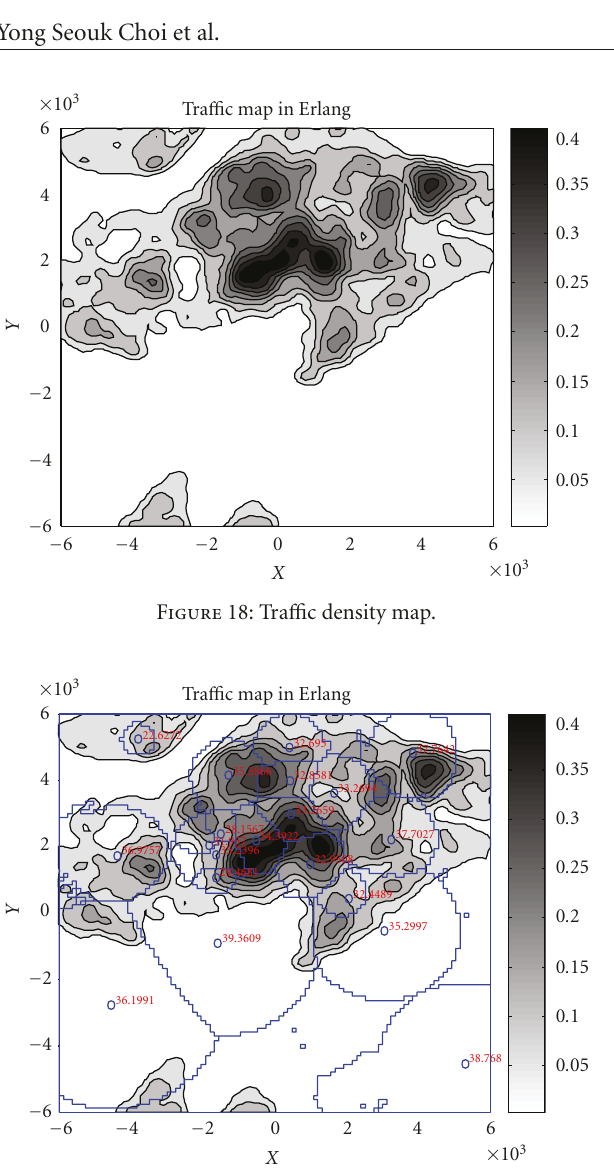
Figure 21: After 500 generations, the location of the base stations,